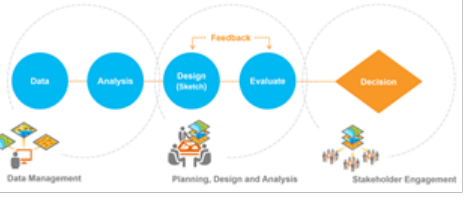
Figure 3. Steps in the process of Geodesign